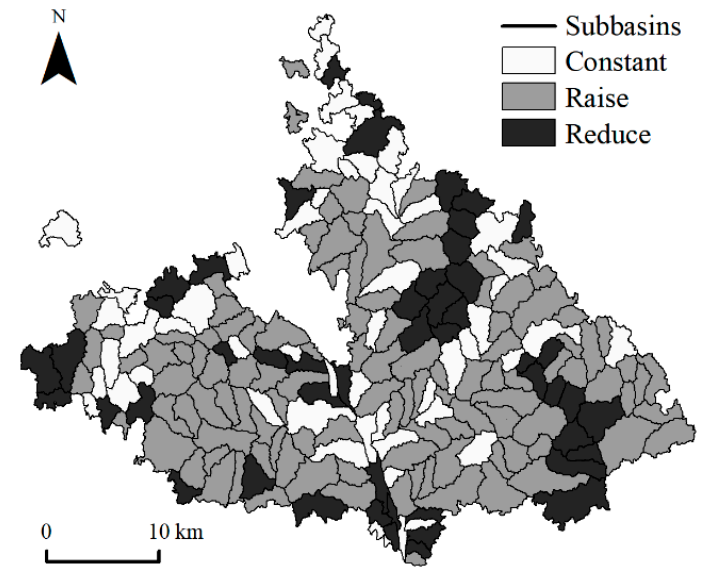
Figure 4. Landscape sustainability grade changes in Mizhi.